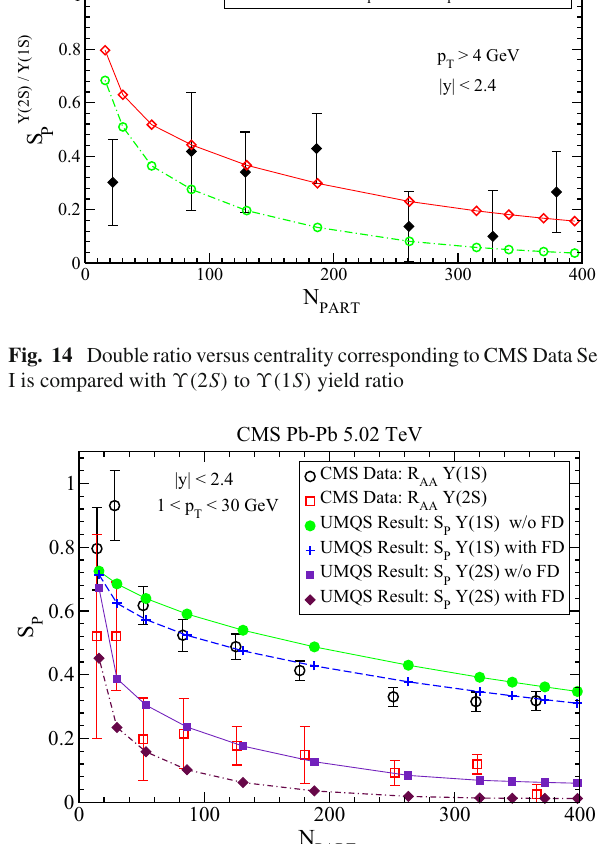
Fig. 13 The p T integrated survival probability of ϒ( nS ) is com- pared with R AA versus centrality in Pb-Pb collisions at TeV [89] at p T range: 2 < p T < 20 GeV